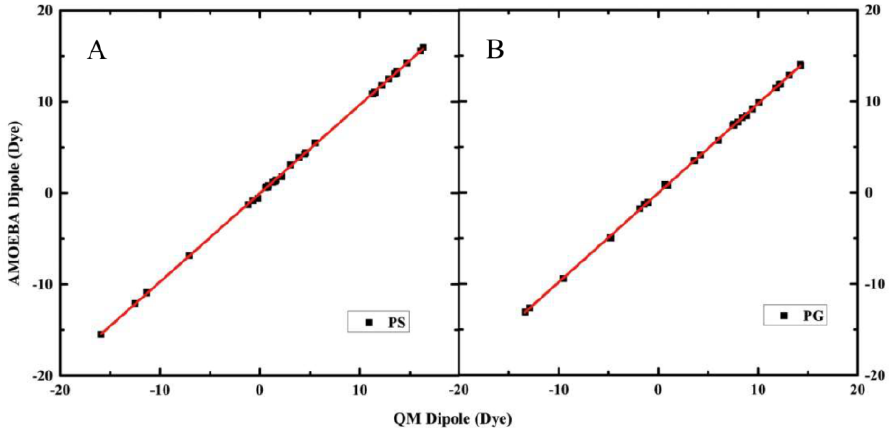
Figure 2. Comparison of headgroup molecular dipole x -, y -, z -components predict by AMOEBA and QM (MP2/6-311++G(2d,2p)) for headgroups. The AMOEBA permanent atomic multipole was obtained from four different conformations and validated on additional 6 conformations. ( A ) Comparison of headgroup molecular dipole x -, y -, z -components predict by AMOEBA and QM for PS headgroup; ( B ) Comparison of headgroup molecular dipole x -, y -, z -components predict by AMOEBA and QM for PG headgroup.